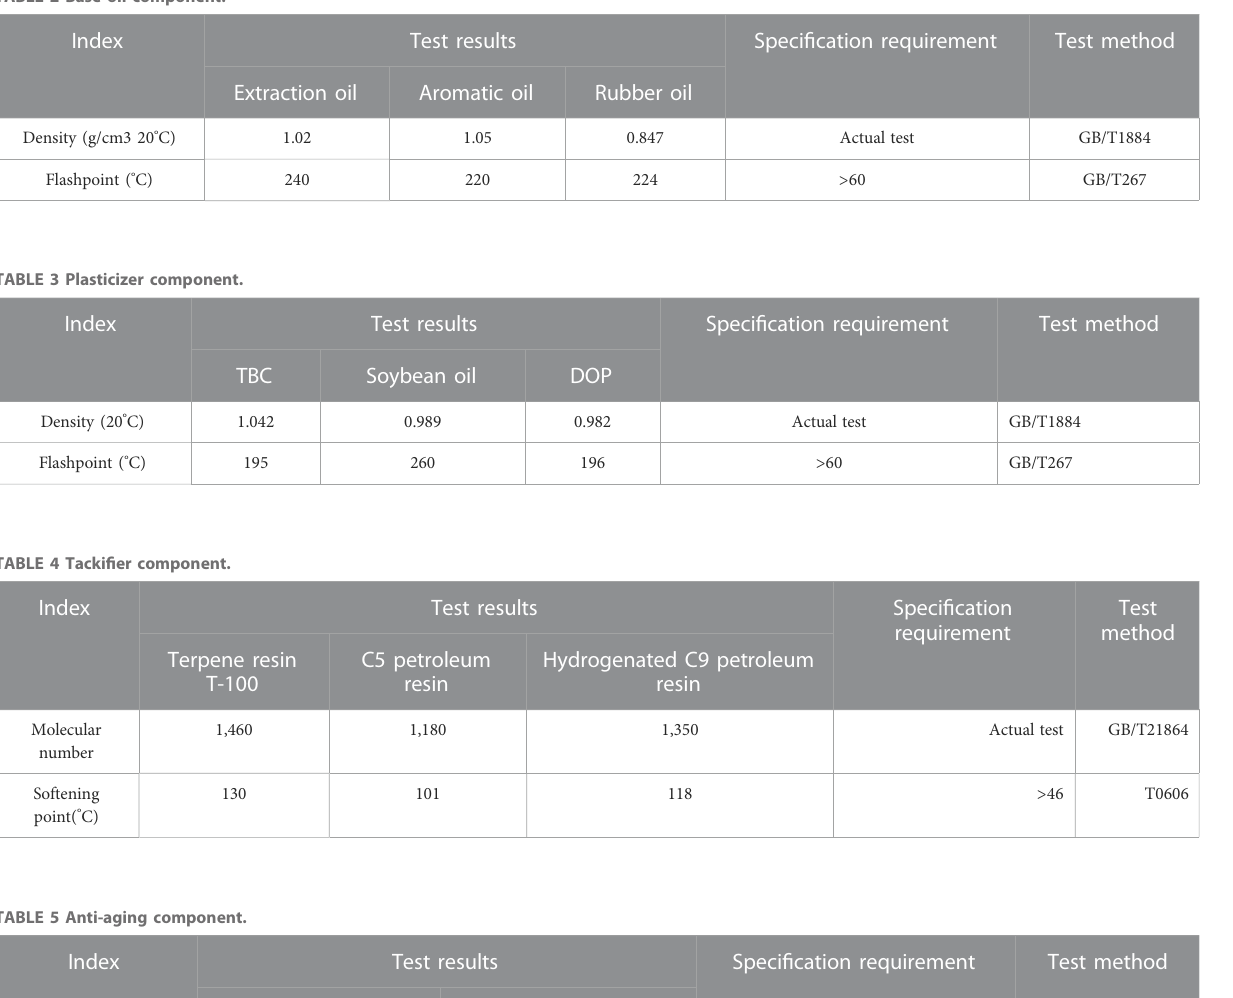
TABLE 2 Base oil component.